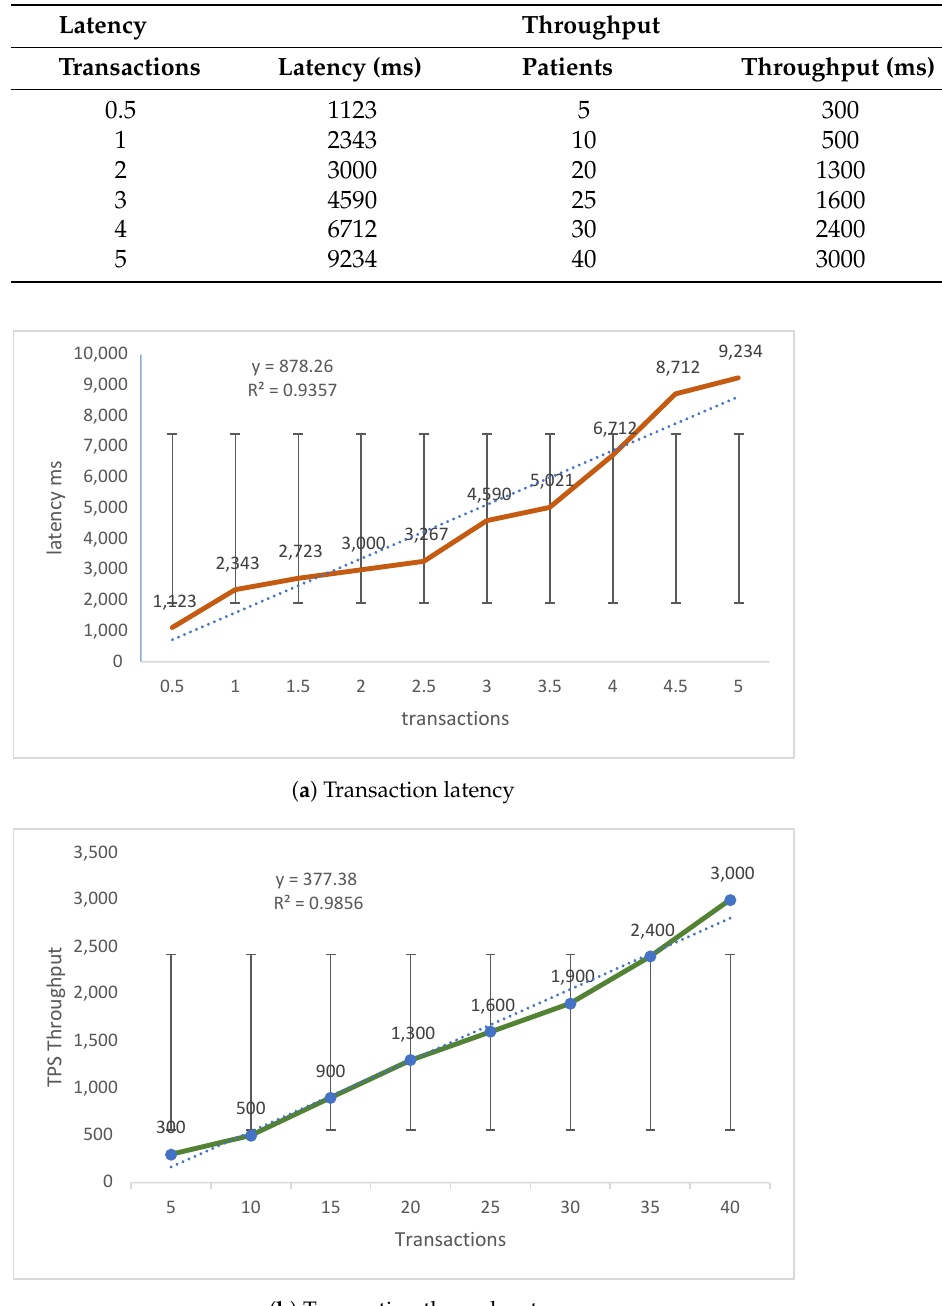
Table 5. Transaction latency and throughput.